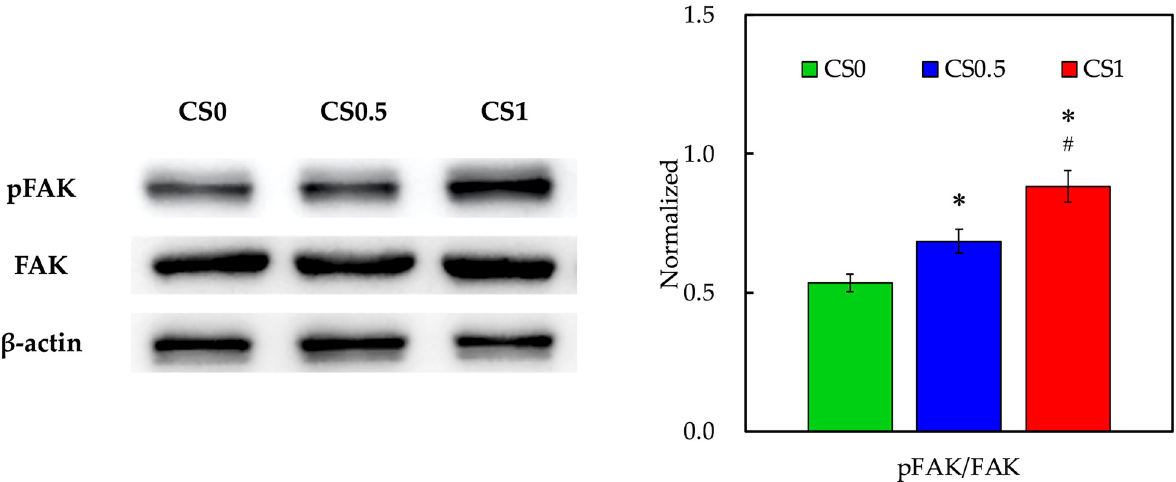
Figure 5. Western blot and quantification of pFAK and FAK expressions of hPDLs cultured in CS0, CS0.5, and CS1. Data presented as mean ± SEM, n = 6 for each group. Quantification of Western blot bands expressed as pFAK/FAK ratios. A p -value of < 0.05 was considered as a significant difference according to the calculation of Scheffe’s multiple comparison test. * represents significant differences when compared to CS0 and # represents significant differences when compared to CS0.5.